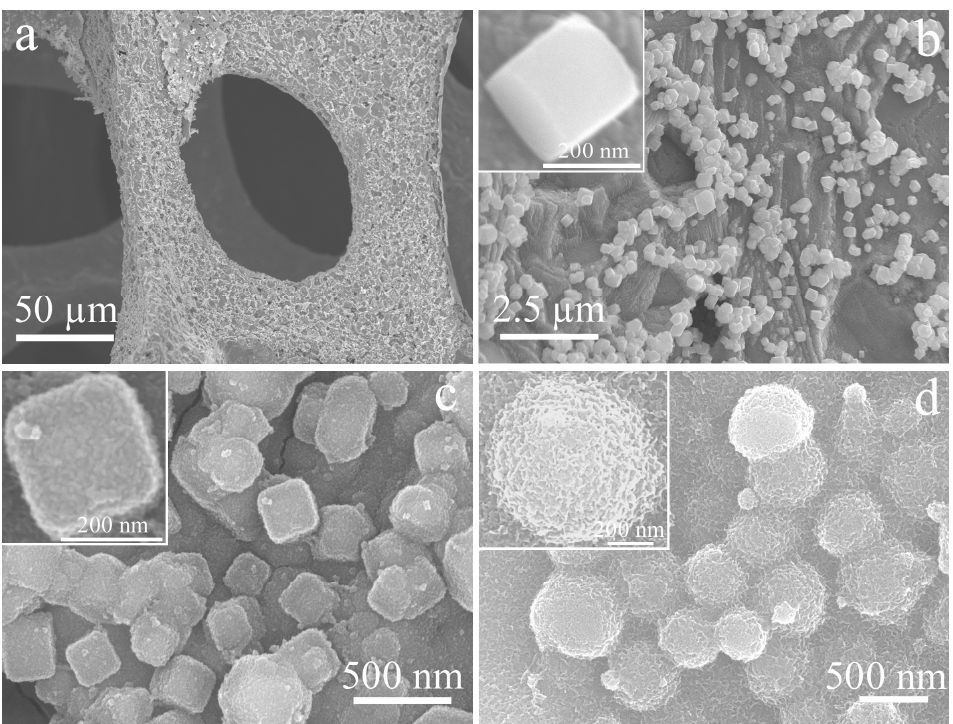
Figure 1. FE-SEM images: ( a , b ) AgNCs and ( c , d ) Ag/Ni(OH) 2 composite with 30 s and 300 s the deposition time of Ni(OH) 2 , respectively.